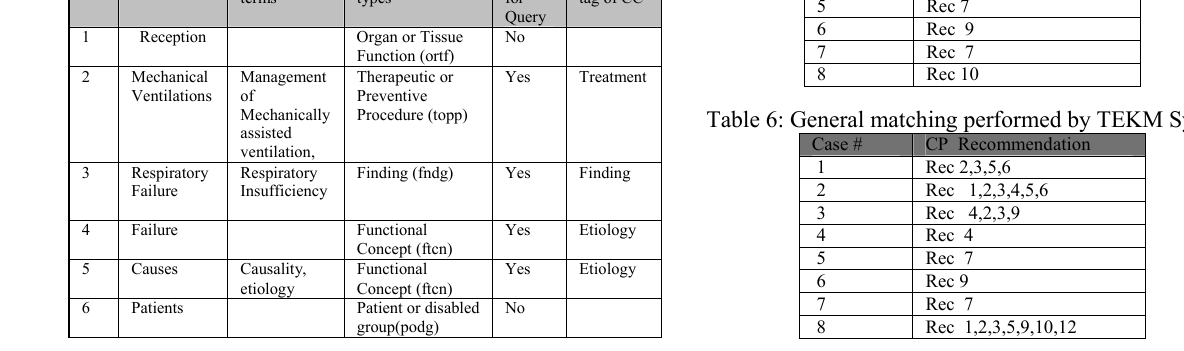
Table 4: Formatted output of MMTx Parser, input from CPG No MeSH term